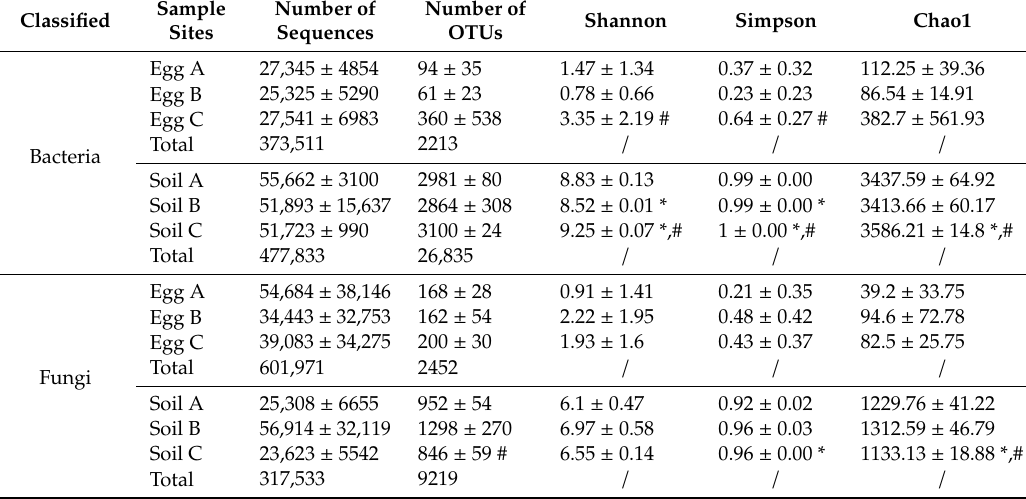
Table 1. The number of high-quality sequences, OTUs and α -diversity indices of microbial communities in unfertilized eggs and soils of di ff erent sampling